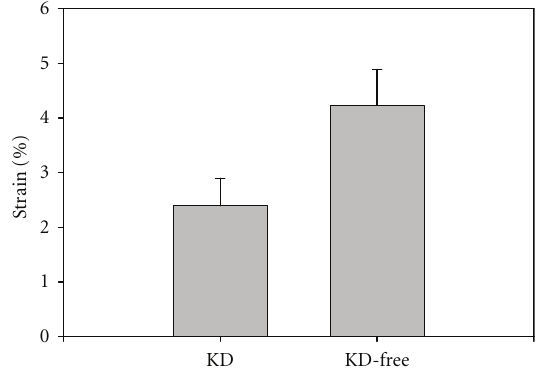
Figure 7: Comparison between KD and KD-free subjects’ ascend- ing aorta sti ff ness. The two groups were found statistically di ff erent, P < 0 .